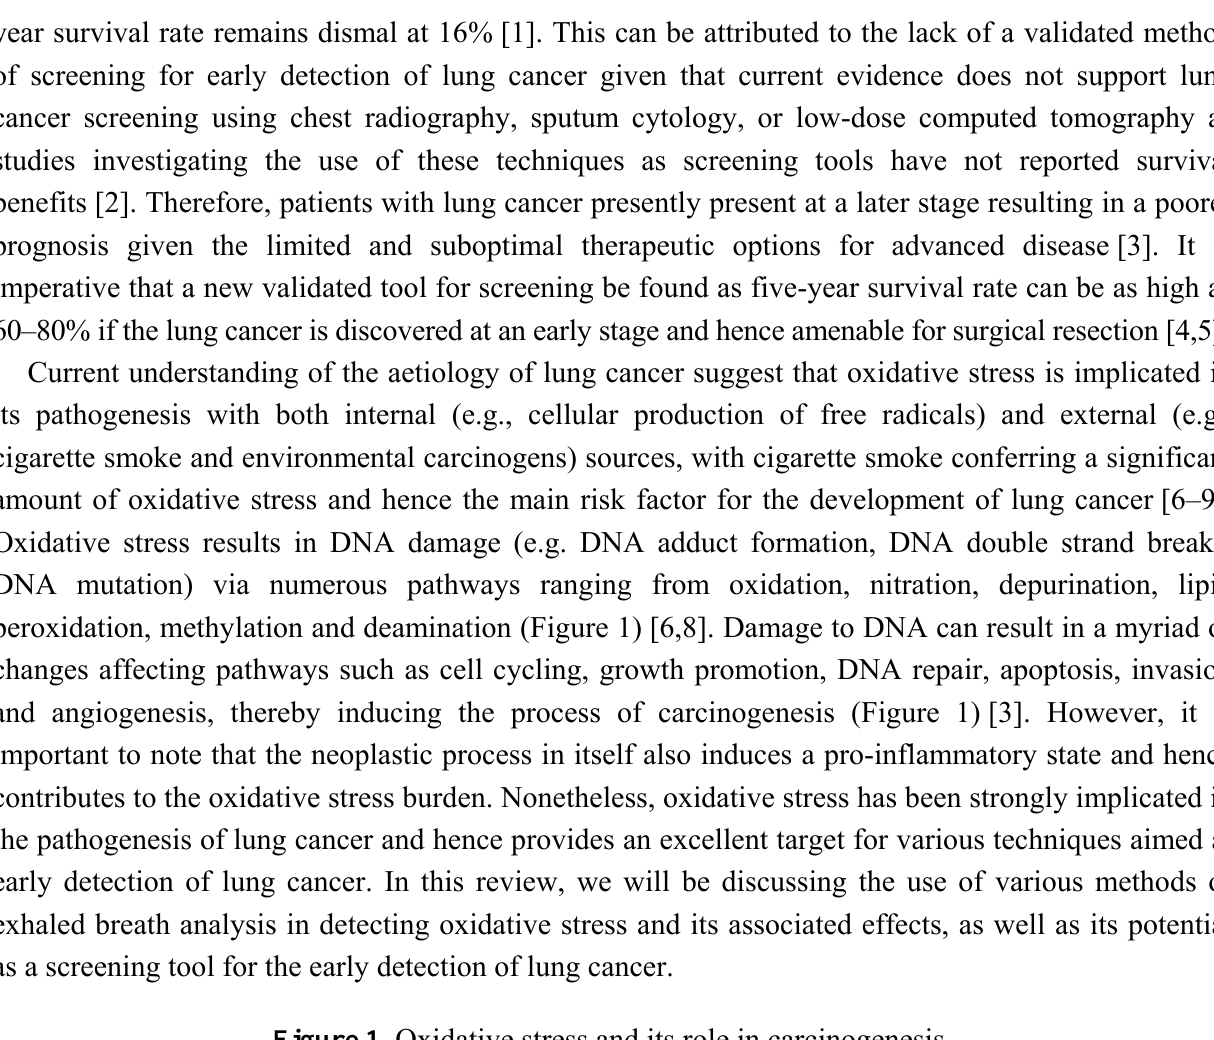
Figure 1. Oxidative stress and its role in